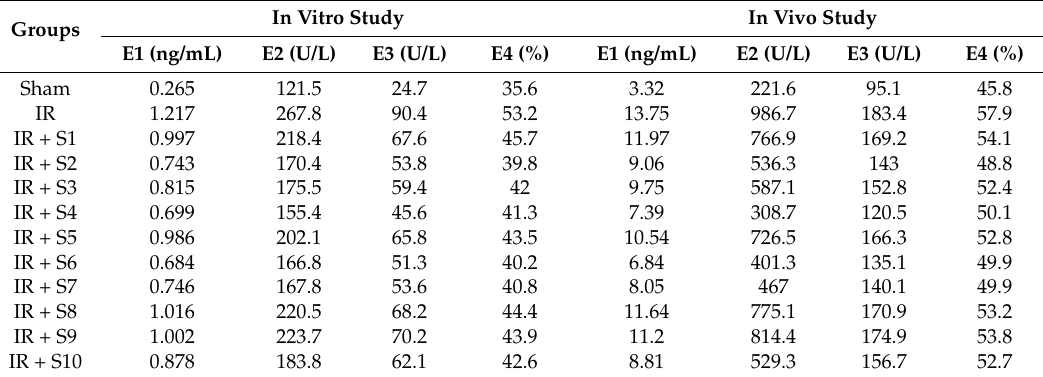
Table 5. The effects of ten different batches of panax ginseng saponins extracts (S1–S10) in vitro and in vivo study in example